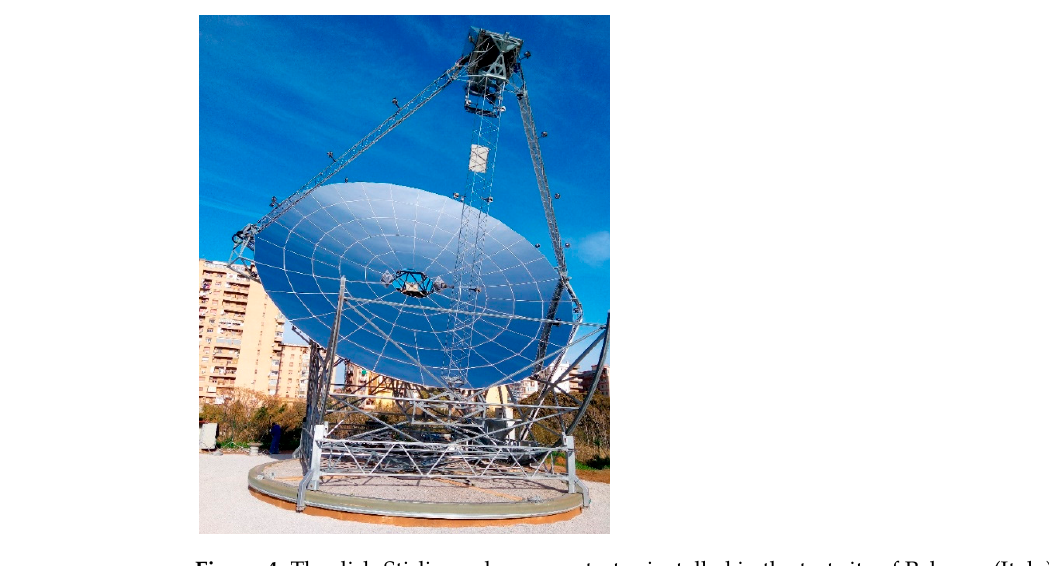
( b ) ( c ) Figure 3. Hourly profiles of the case study: ( a ) cooling, ( b ) thermal and ( c ) electricity demands [40].